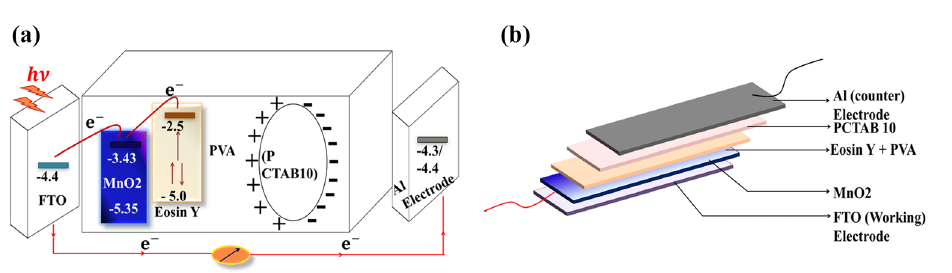
Figure 2. ( a ) Schematic presentation of photo charge carriers generation and storage mechanism of the PESD with HOMO and LUMO energy levels, ( b ) Schematic photograph of the